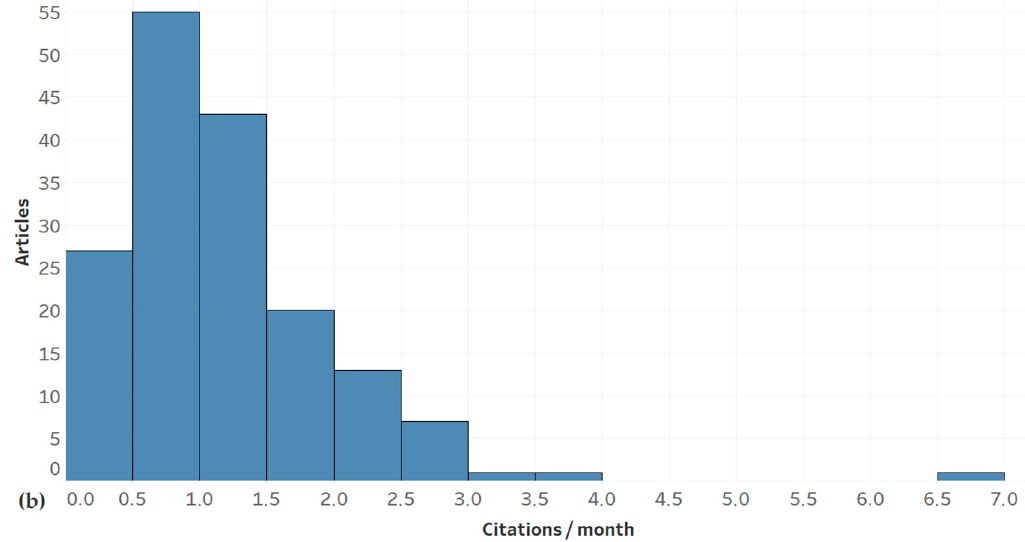
Figure 14. ( a ) Scatterplot of the article citations with respect to the publication time in months. ( b ) Histogram of the citations per month. Self-elaboration.